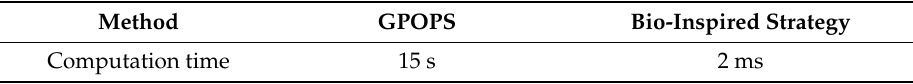
Table 3. Computation times for GPOPS and the bio ‐ inspired strategy.